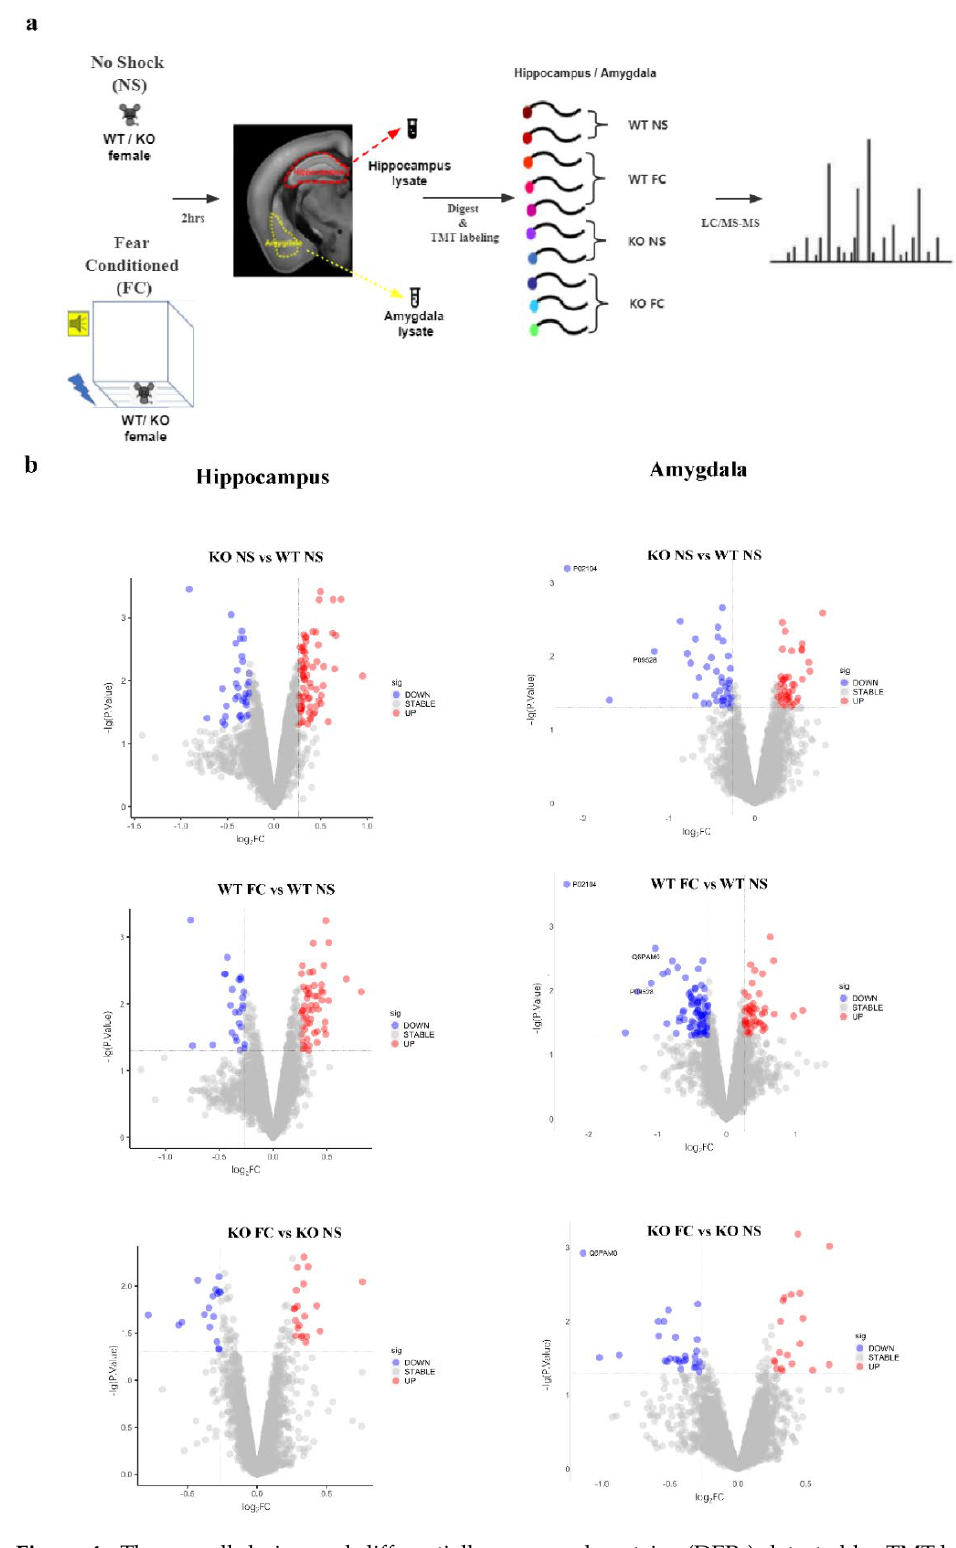
Figure 4. The overall design and differentially expressed proteins (DEPs) detected by TMT-based proteomics. ( a ) The schematic diagram of fear conditioning, protein collection, and TMT labeling. The hippocampus or amygdala of the right hemispheres from 4 female mice were collected for labeling in the WT NS and KO NS group, respectively ( n = 4, the tissue from 2 mice were mixed and labeled with one TMT reagent). Hippocampus or amygdala of the right hemispheres from 6 female mice were